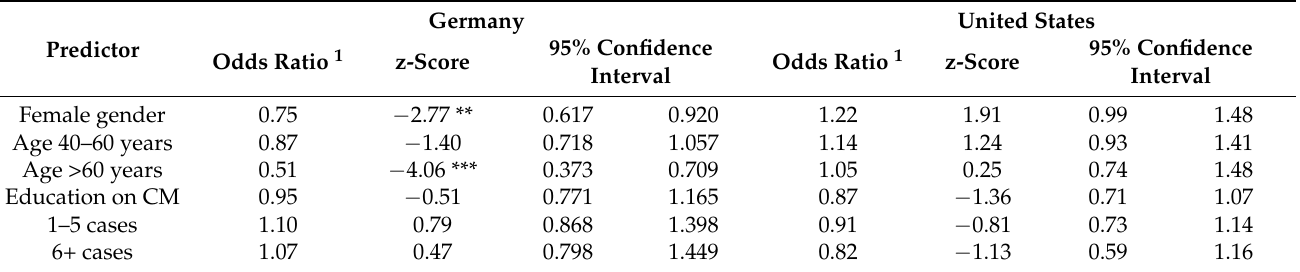
Table 2. Predictors for reasonable suspicion using a differential diagnosis scale.